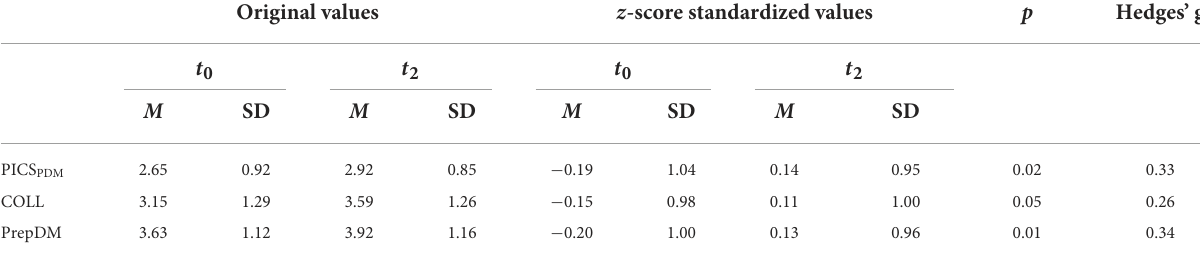
TABLE 2 Endpoints before and after implementation (original and z -score standardized values). Original